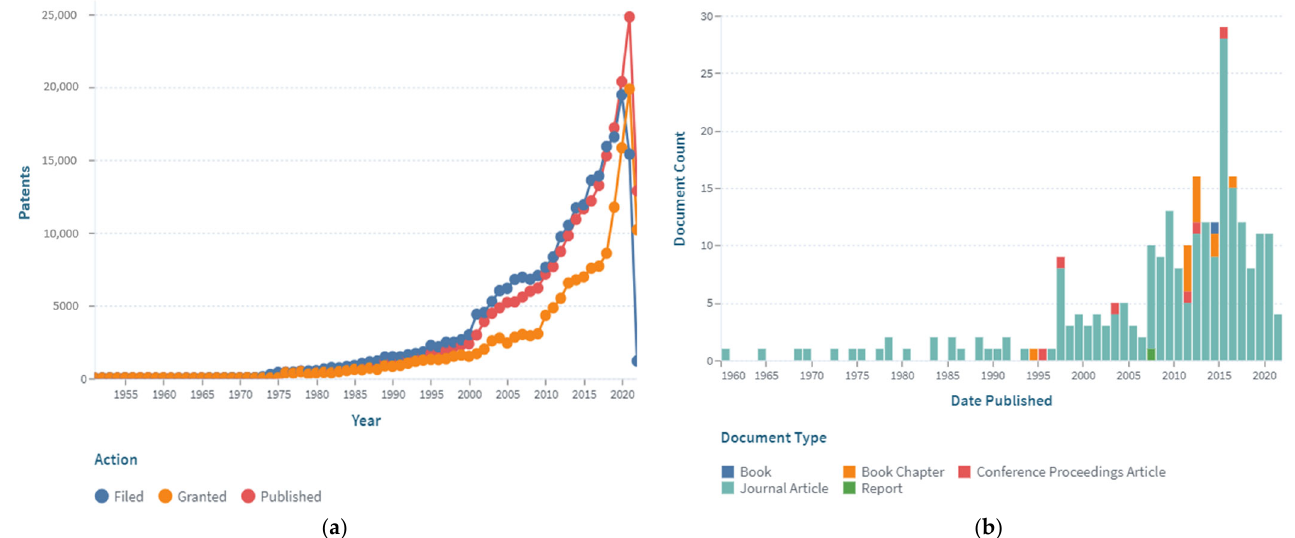
Figure 1. The publication analysis on anti-corrosion: ( a ) patents and ( b ) cited works in recent years [51,52].